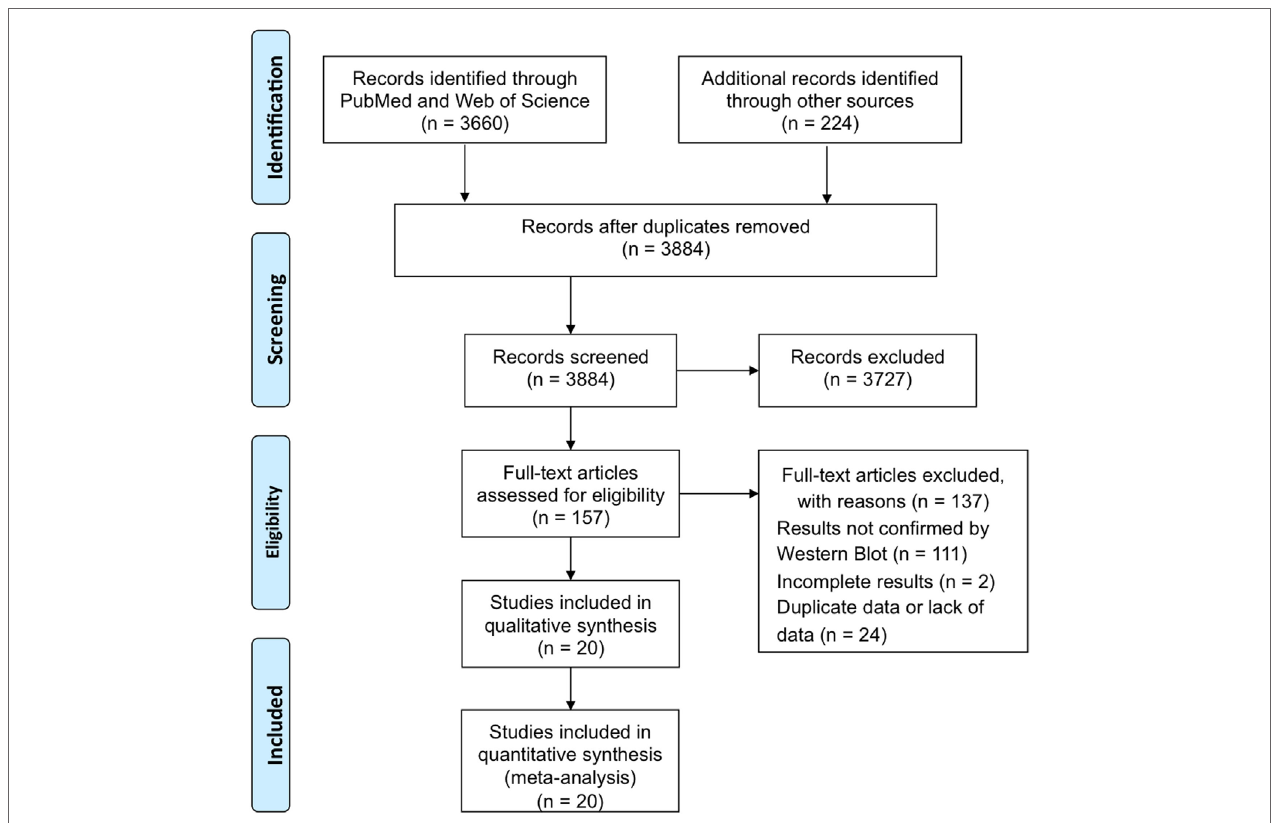
FigURe 1 | Flow chart of the screening process of the